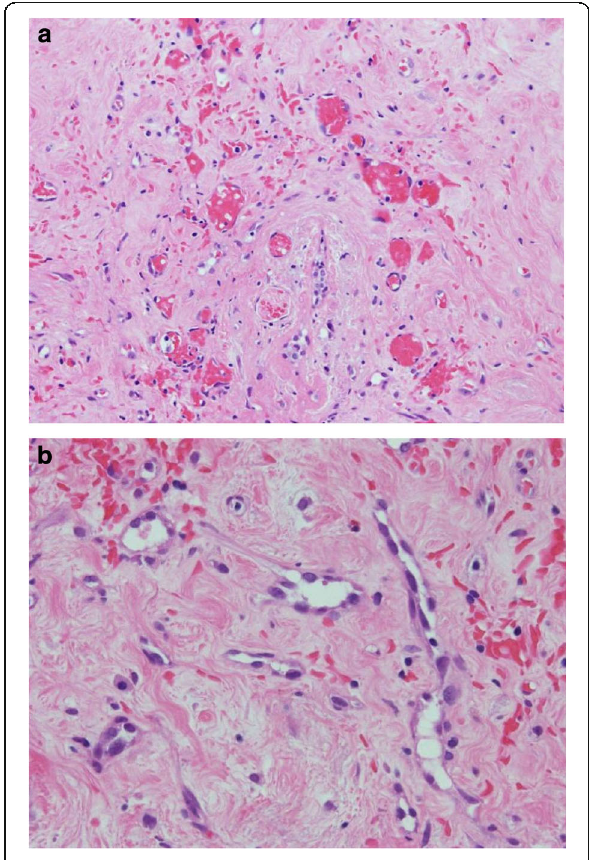
Fig. 2 Pathological analyses of core-needle-biopsy. The endothelial cells were swollen; however, atypical epithelial cells were absent. a × 40; b ×